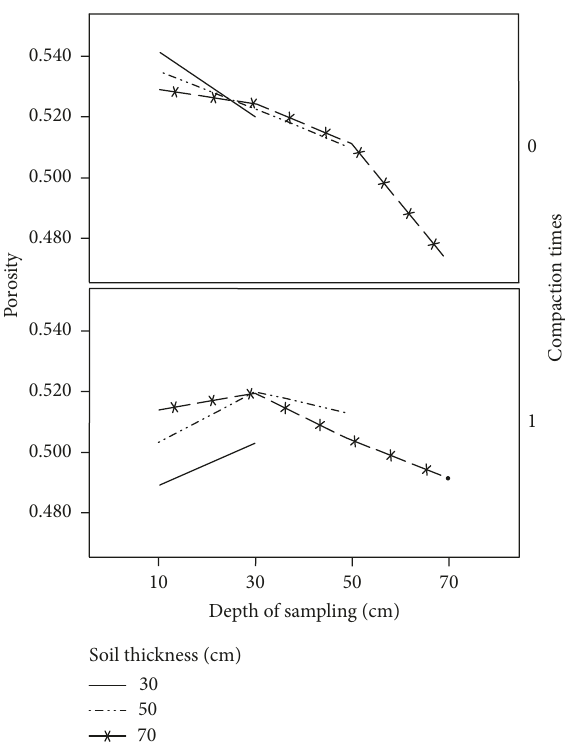
Figure 9: Change of the porosity of different times of compaction and soil thickness to the depth of sampling.